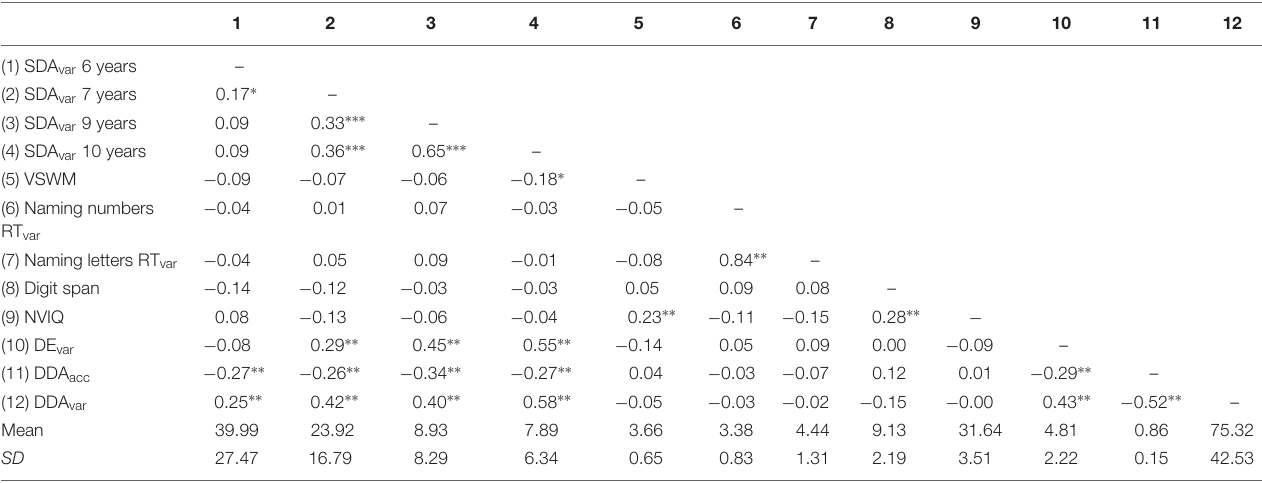
TABLE 3 | Bivariate correlations and means (standard deviations) for all measures.